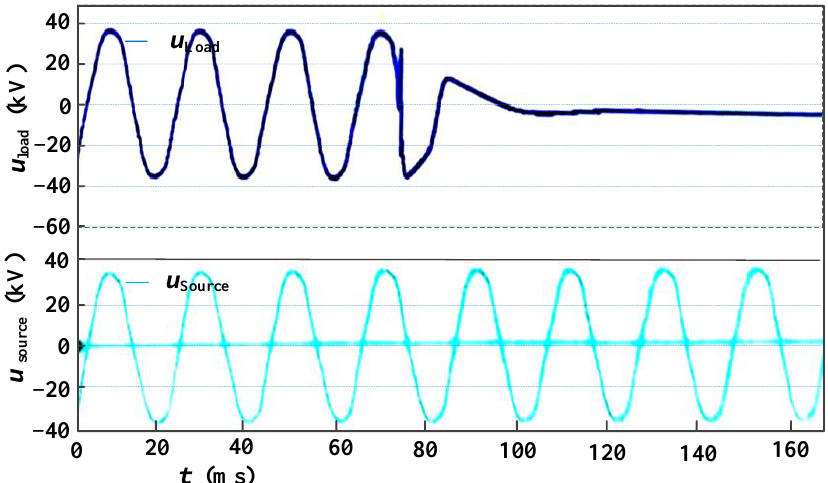
Figure 22. Transient-state waveforms of overvoltage when the vehicle-mounted circuit breaker is opened at the peak.